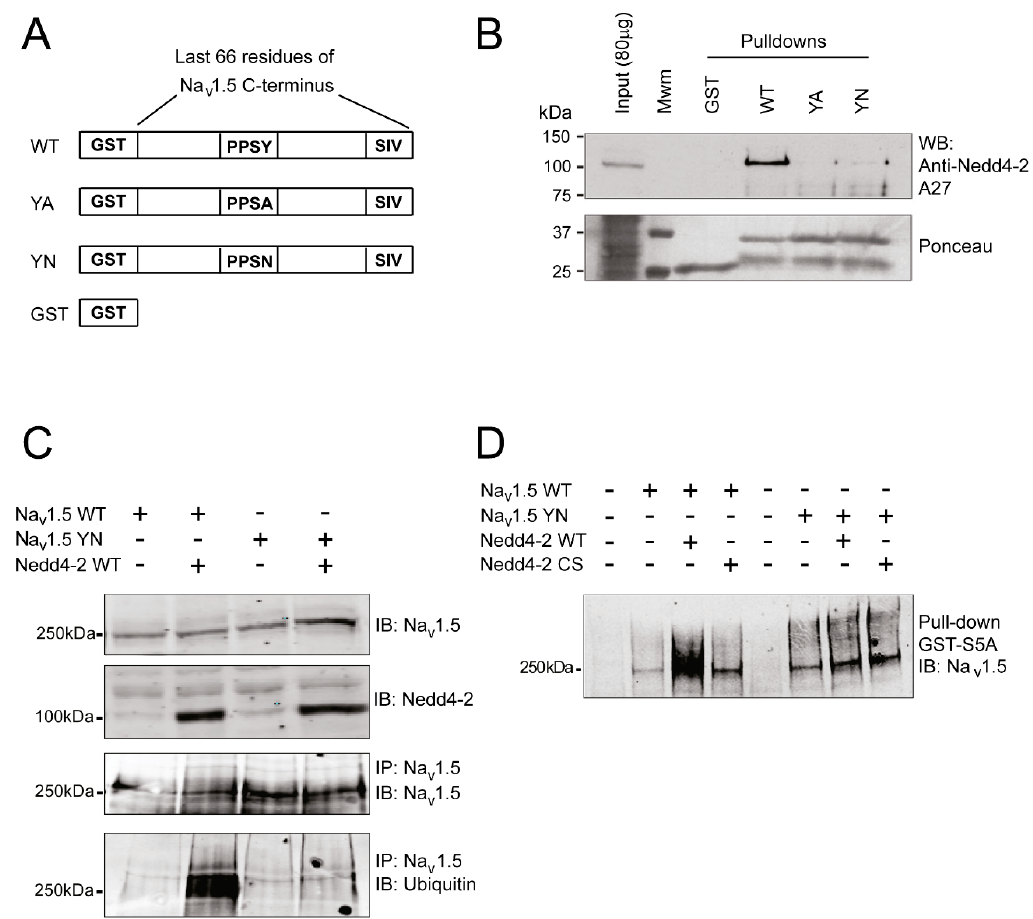
Figure 1. The SCN5A -p.Y1977N mutation abolishes the interaction between Na v 1.5 and Nedd4-2 and Nedd4-2 ubiquitylation of Na v 1.5. ( A ) Schematic representation of the four fusion proteins used for the pull-down experiments described in ( B ). PPSY (proline-proline-serine-tyrosine) represents the wild-type (WT) sequence of the PY-motif of Na v 1.5, while PPSA and PPSN represent mutations of the tyrosine (Y) of the PY-motif in alanine (A) and asparagine (N), respectively. ( B ) Western blots of pull-down fractions performed on HEK293 lysates against Nedd4-2. The bottom panel shows a Ponceau staining of a representative nitrocellulose membrane, showing the presence of Glutathione S-Transferase (GST) fusion proteins for the different pull-down experiments. ( C ) Immunoprecipitation of Na v 1.5 followed by blotting against either Na v 1.5 or ubiquitin demonstrating ubiquitylation of the WT channel, but not of the YN channel, in the presence of Nedd4-2 WT. ( D ) Total ubiquitylated proteins from HEK293 lysates precipitated using GST-S5A fusion proteins and subsequently blotted with an antibody against Na v 1.5, demonstrating a lack of WT Na v 1.5 ubiquitylation in the presence of a catalytic inactive form of Nedd4-2 (Nedd4.2 CS) as well as absence of ubiquitylation of YN Na v 1.5 in the presence of WT Nedd4-2. Data were collected from three experiments.